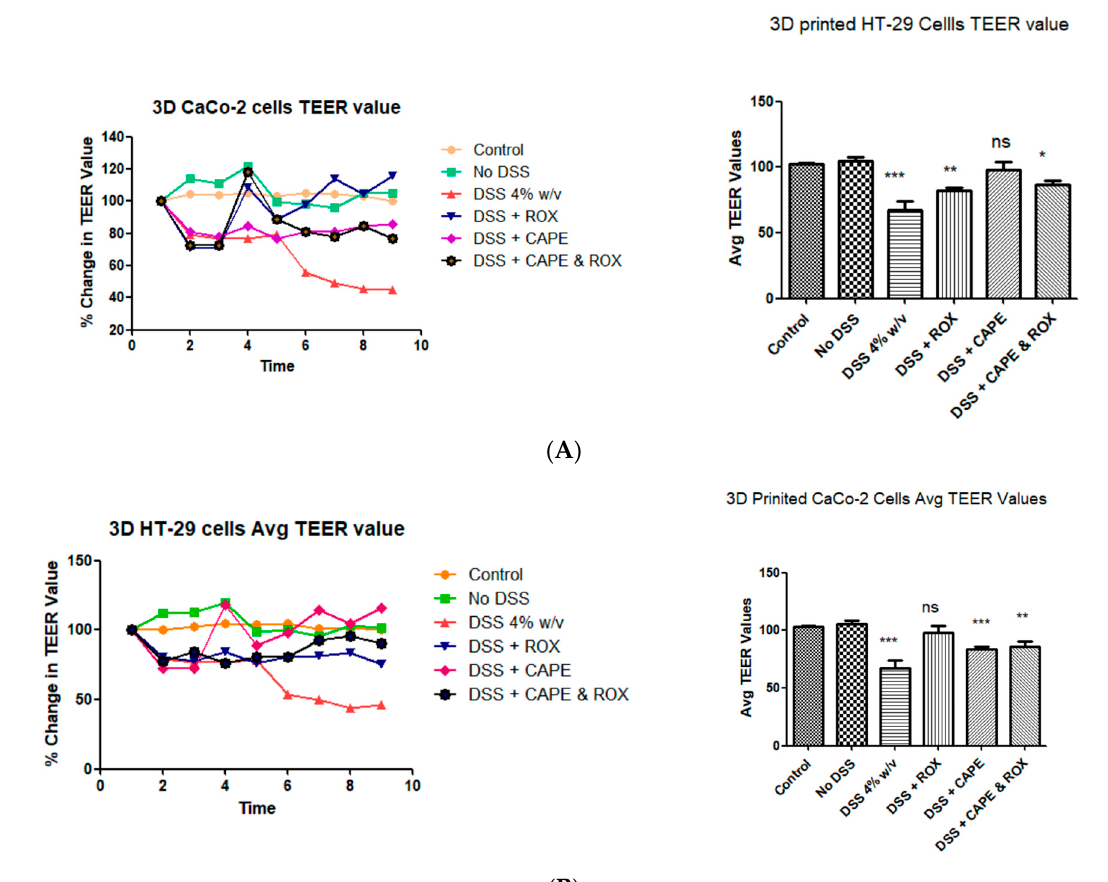
Figure 5. Percentage change in TEER values in 3D-printed constructs after albumin nanoencapsulated anti-inflammatory drugs. ( A ) shows the percentage change in the TEER value in the 3D-printed Caco-2 constructs, and ( B ) shows the percentage change in the TEER value in the 3D-printed HT-29 constructs. Data are represented as mean ± SD; * p < 0.05, ** p < 0.01, *** p < 0.001 was considered statistically significantly different compared to the control.